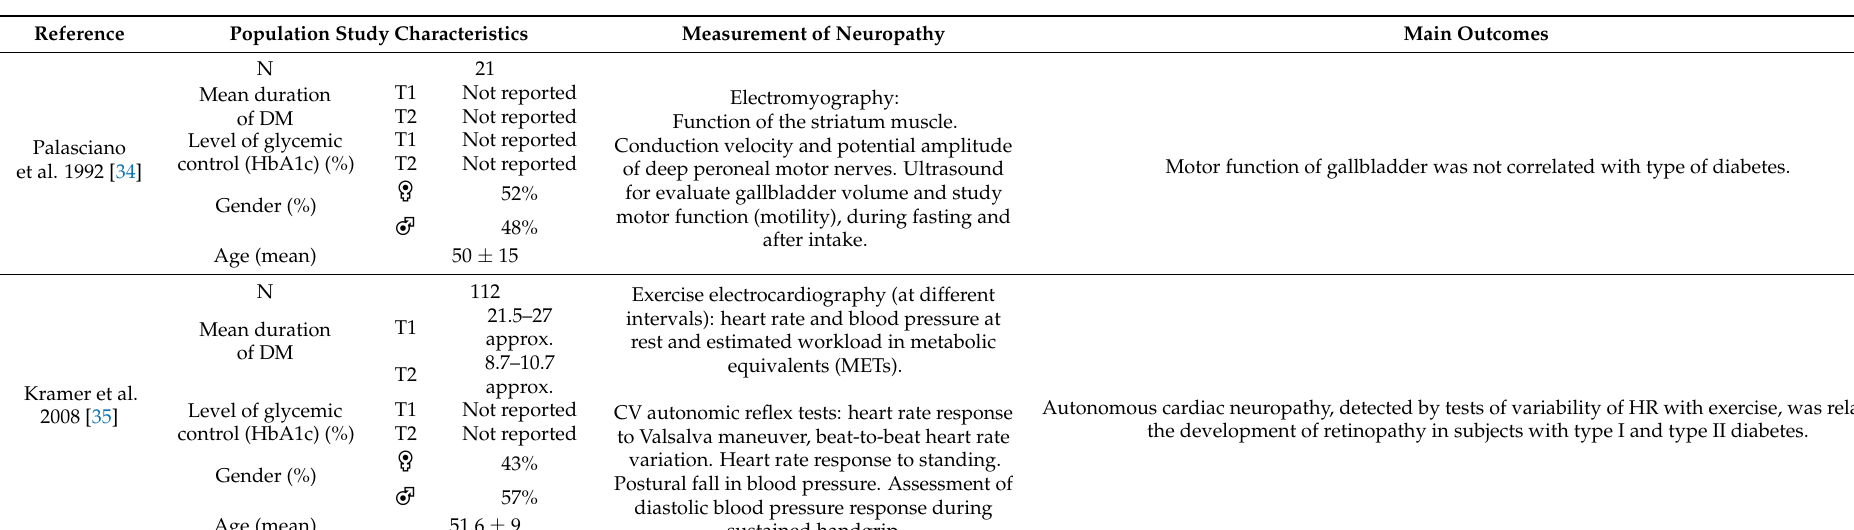
Figure 1. Systematic review workflow.